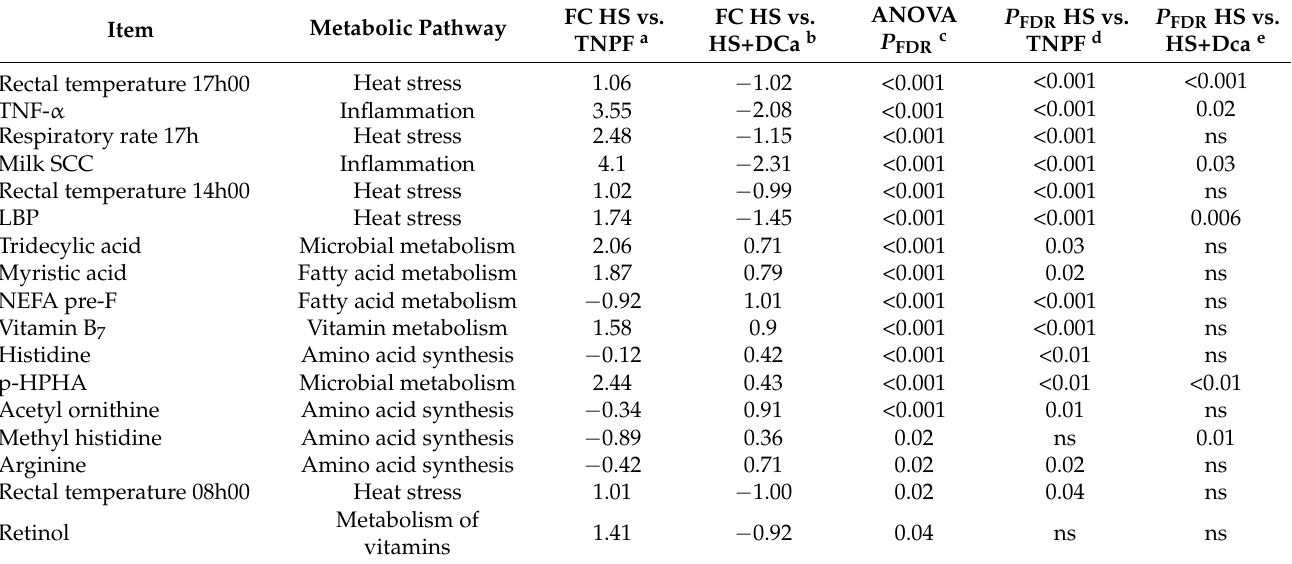
Table 1. Physiological parameters and fecal metabolites affected by treatment * in ANOVA, as identified by